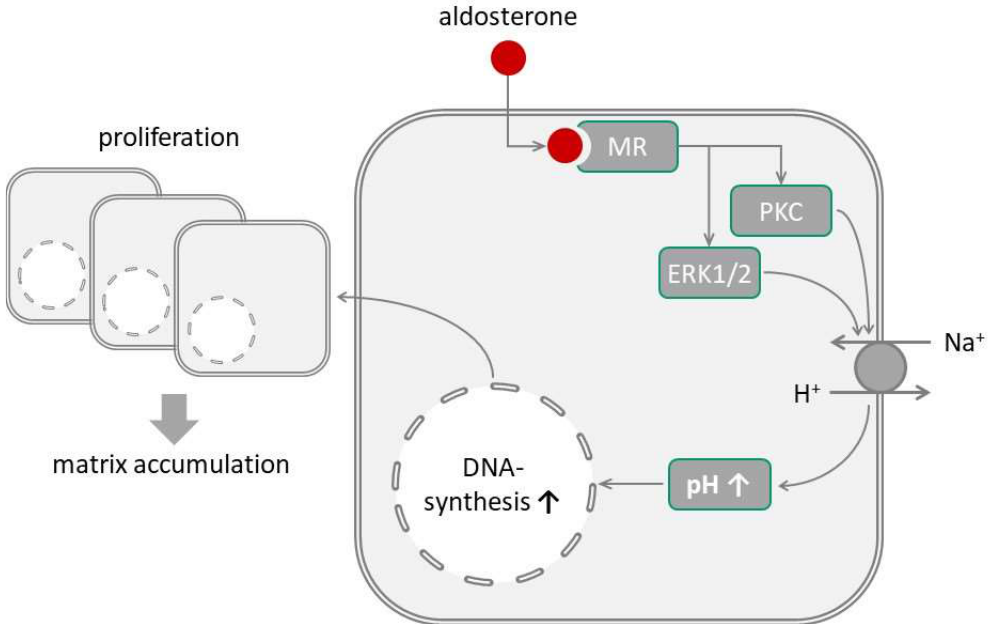
Figure 5. Graphical summary of the described effects of aldosterone. MR = mineralocorticoid receptor. PKC = protein kinase C. ERK1/2 = extracellular signal regulated kinase 1/2.